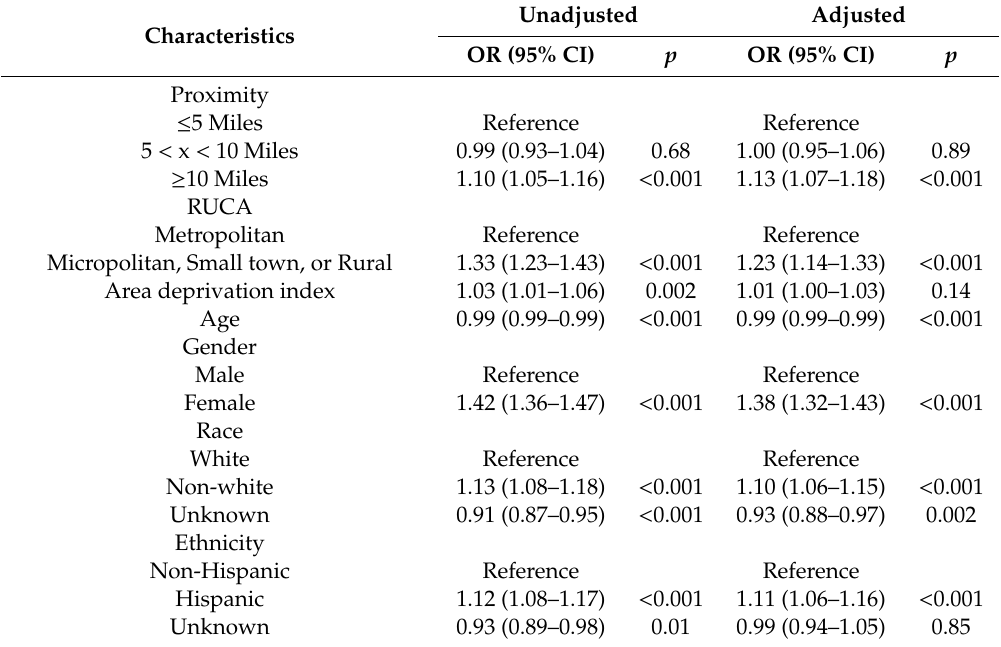
Table 3. Unadjusted and adjusted multilevel negative binomial with log link analyses of characteristics associated with the number of days to treatment in Yakima County, Washington between 2007 and